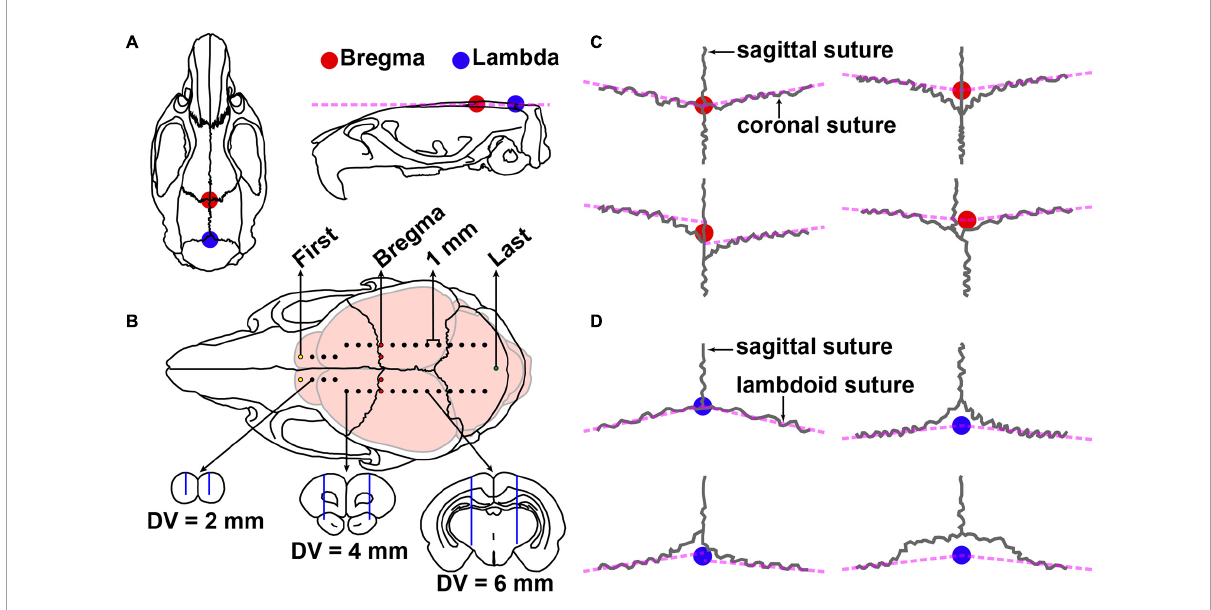
FIGURE1 Schematic diagram of stereotactic surgery and variations of bregma and lambda. (A) Dorsal and lateral views of the skull of adult Sprague–Dawley rat. The colorful circles represent the position of bregma (red) and lambda (blue). (B) Top, injection site of methylene blue in P9 Sprague–Dawley rat pups. The coordinate sites were related to the size of different parts of the brain: the medial and lateral were 0, 1, or 2 mm, the step distance between adjacent anterior and posterior was 1 mm, and the dorsal and ventral (DV) were 2, 4, or 6 mm. The first, bregma, and last sites are shown in yellow, red, and green, respectively. Bottom, the schematic drawing shows the representative brain sections and the needle track (blue line) marked by methylene blue. (C) Four variations of the bregma point. (D) Four variations of lambda